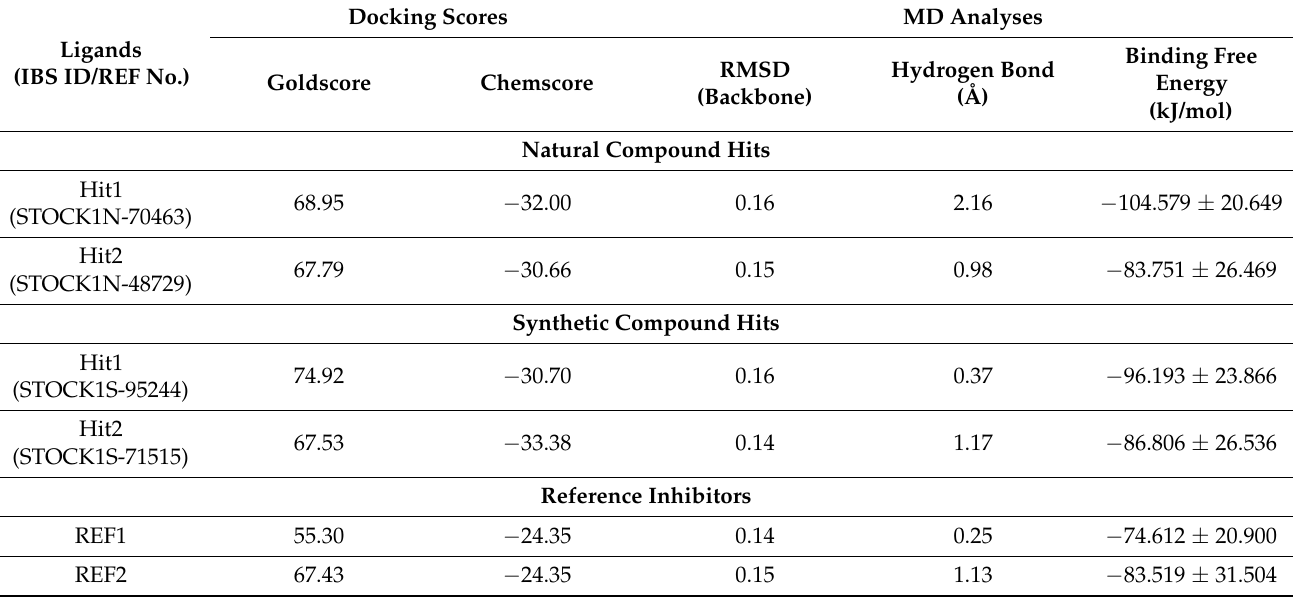
Table 3. Molecular docking and molecular dynamics simulation analyses for reference (REF) inhibitors and selected potential hits from InterBioScreen (IBS) database against Heparanase.